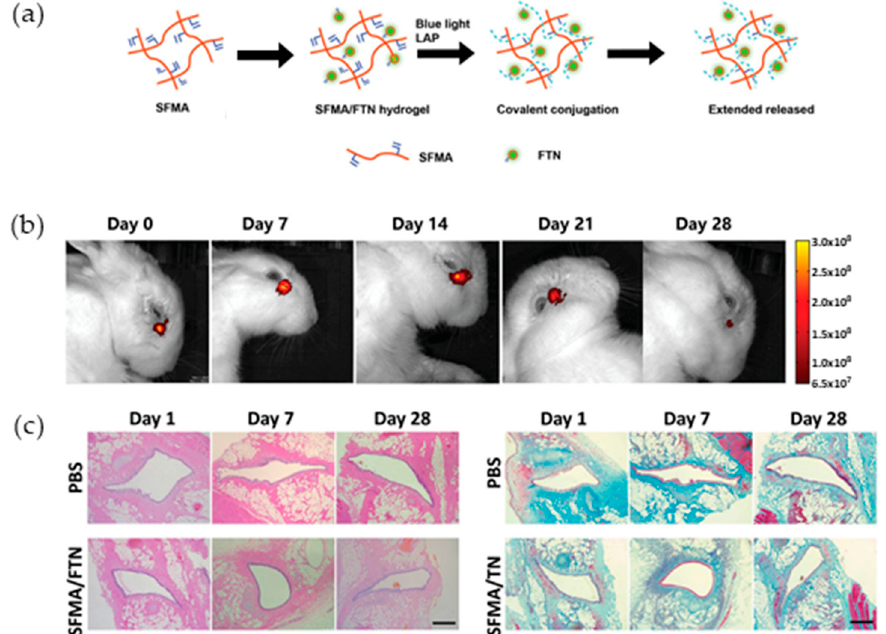
Figure 3. Synthesis and application of methacrylate-modified silk fibroin(SFMA)/fluorescent tracer nanoparticles (FTN) hydrogel plugs. ( a ) Schematic of the release of FTN from the SFMA hydrogel; ( b ) Long-term monitoring of SFMA/FTN hydrogel localized in the lacrimal sac of dry eye rabbits; ( c ) H&E and Masson staining observations for the biocompatibility assay after 1, 7, and 28 days of PBS and SFMA/FTN hydrogel in situ injection at the lacrimal duct, respectively (scale bars: 200 μ m). Images reproduced with permission [64] ©WILEY-VCH Verlag GmbH & Co. KGaA, Weinheim.